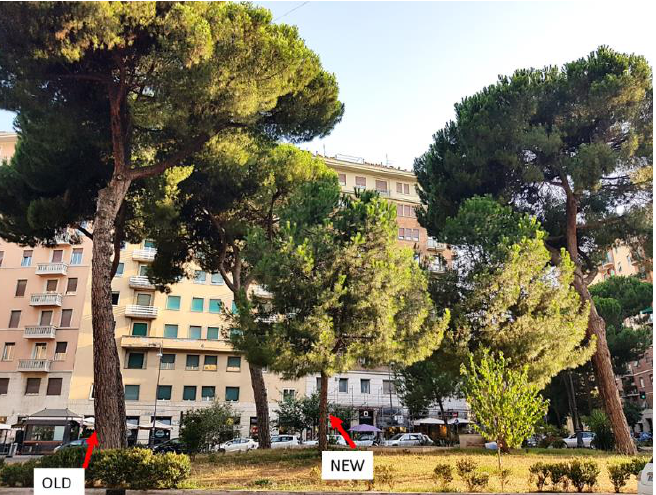
Figure 5. A picture of Corso Trieste characterised by historical specimens (old) and young specimens (new) of Pinus pinea L.